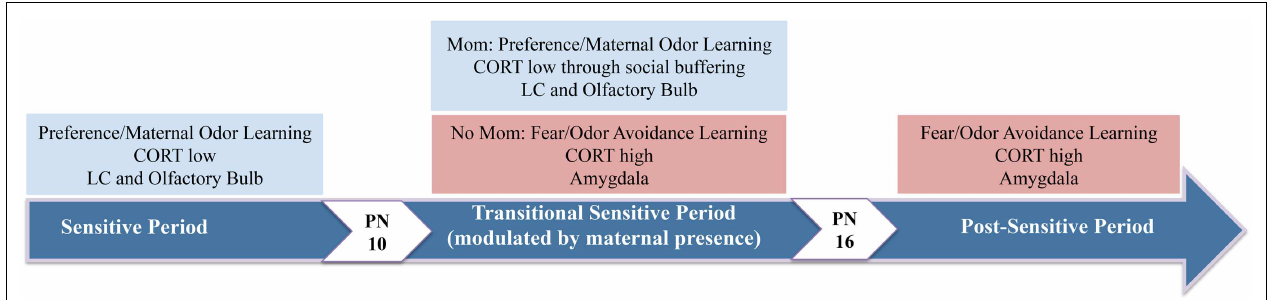
FIGURE 1 |The neural circuitry underlying pup attachment learning changes over development . During the earliest days of life, pups have a sensitive-period in which odor-shock conditioning produces an odor preference. At 10days of age, pups begin the transitional sensitive-period, when pups endogenous CORT levels have increased sufficiently to enable amygdala-dependent fear/avoidance learning. However, with the mother